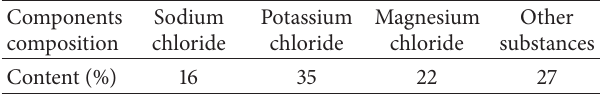
Table 2: The components composition of the new solidifying